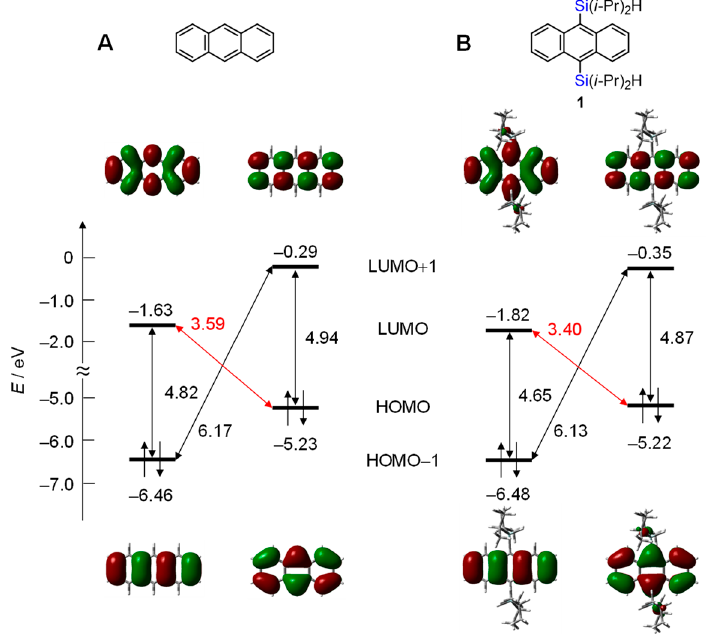
Figure 4. The HOMO, HOMO – 1, LUMO, LUMO+1 and their energy levels of 1 ( B ) and anthracene ( A ) calculated at the B3LYP/6-31G(d) level.